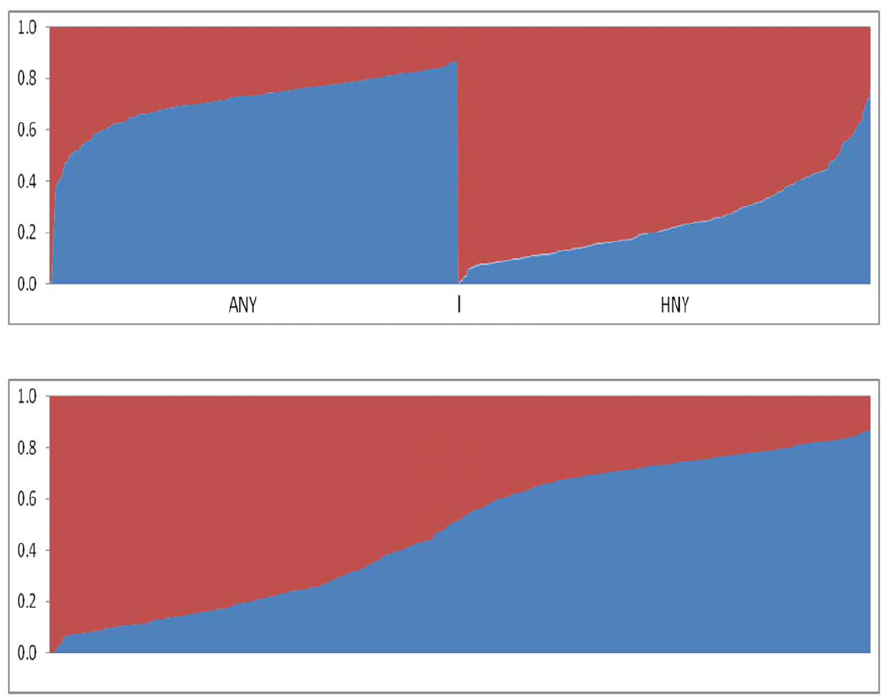
Figure 4. Population structure results for K =2 ancestral populations sorted by ancestry proportions for African American biobank sample (ANY) and Hispanic American biobank sample (HNY) (Top) and pooled sample of both ANY and HNY (Bottom).